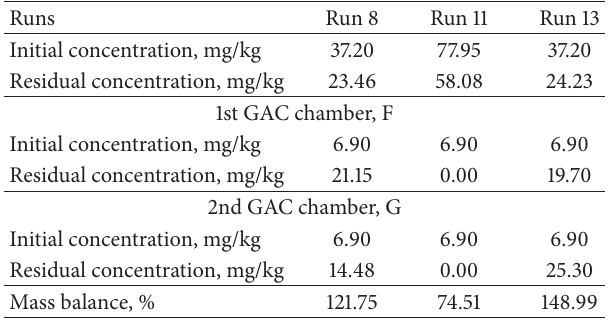
Table 6: A sample mass balance analysis of trivalent Cr for Runs 8, 11, and 13.